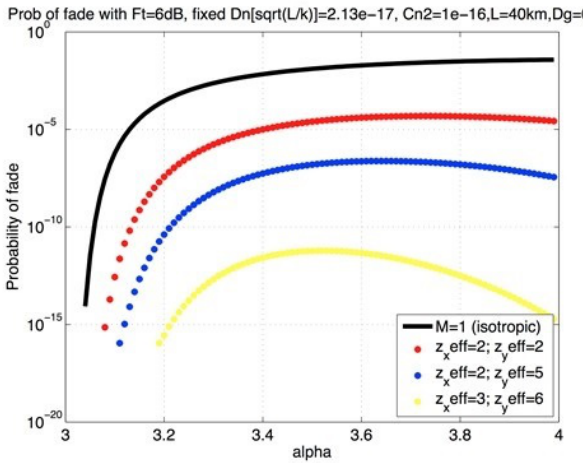
Figure 18. Probability of fade as a function of α for several cases of anisotropy and fixed structure function (shown as z x eff and z y eff in the legend). Reprinted with permission from Reference [100].